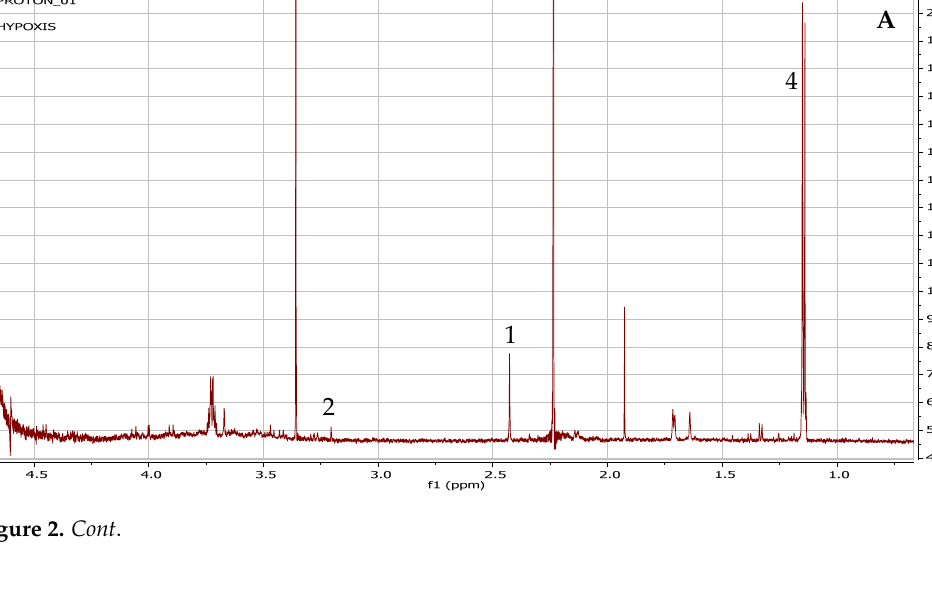
Figure 1. The 1 H-NMR full spectrum of Hypoxis hemerocallidea leachate metabolite profile. Four chemical compounds annotated from the leachate with potential inhibitory or growth-retarding effects were numbered 1, 2, 3, and 4, with 1 and 2 representing organic acids, whereas 3 represented peaks of the sugar region, and 4, the peaks for propylene glycol (Figure 2).